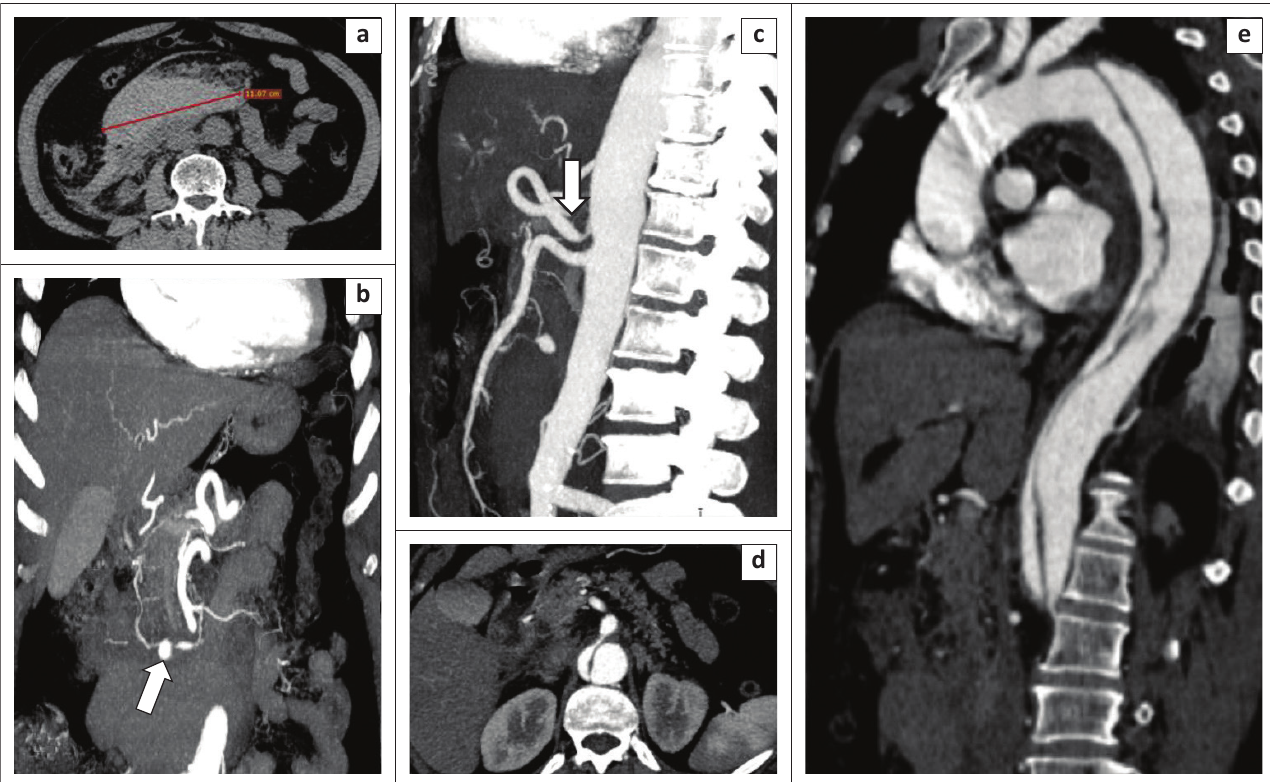
FIGURE 3: A 44-year-old woman admitted with haematemesis and melena. Non-enhanced computed tomography in the axial plane (a) showing a homogeneous hyperdense haematoma of approximately 11 cm. Arterial phase in coronal (b), sagittal (c), axial (d) and oblique plan (e) revealed a small aneurysm (arrow, b) originating from the inferior pancreatic-duodenal artery (IPDA) (arrow, b); Moderate coeliac artery compression by the median arcuate ligament (arrow, c) is identified. There is a Standford B aortic dissection (e) where the coeliac artery originantes from the false lumen